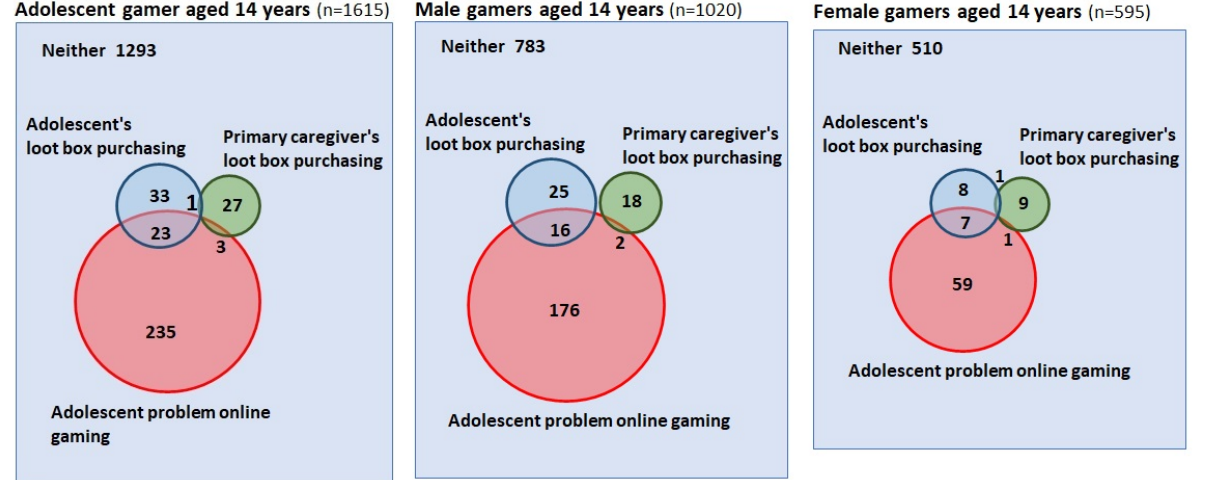
Figure 2. Venn diagrams of loot box purchasing and problem gambling in adolescent